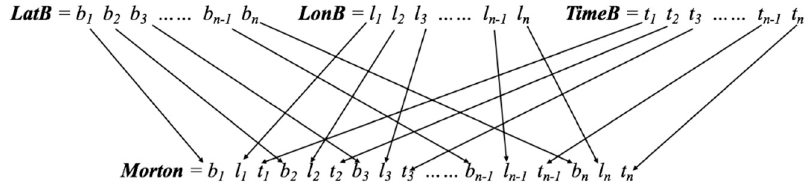
Figure 4. encoding procedure of the GeoSOT ST-code. Figure 4. Encoding procedure of the GeoSOT